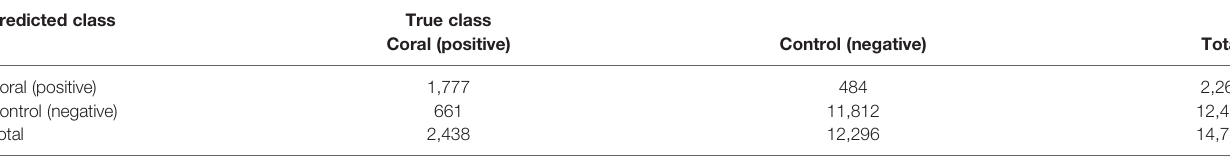
Accuracy metrics are summarized below the table. The probability cutoff utilized for differentiating coral samples from control samples was 0.42 (see Geomorphometric CWC Reef Classi fi cation). Overall classi fi cation accuracy (OCA): 0.92; sensitivity: 0.73; speci fi city: 0.96; positive predictive value (PPV): 0.79; negative predictive value (NPV): 0.95; kappa coef fi cient: